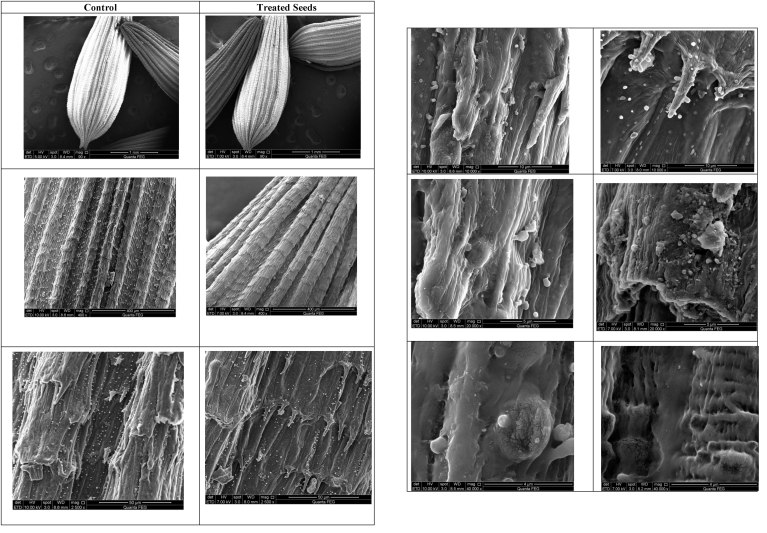
Scanning electron microscope examination of the surface and appearance of lettuce seeds. 1. Low to high magnification of untreated vs. treated. Left Panel: untreated seeds, Right Panel: seed treated with 25 μg/ml ZnO NPs.